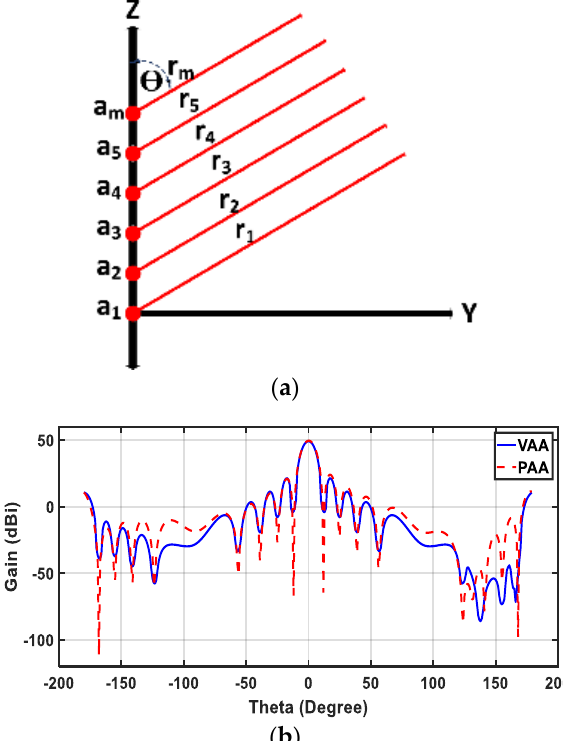
Figure 2. ( a ) Linear isotropic antenna array and ( b ) comparison between radiation pattern of the planar antenna array (PAA) and the virtual antenna array (VAA).